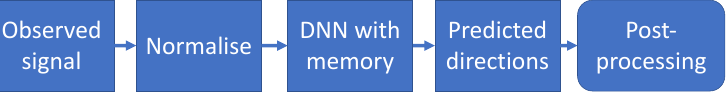
Figure 2. The used prediction